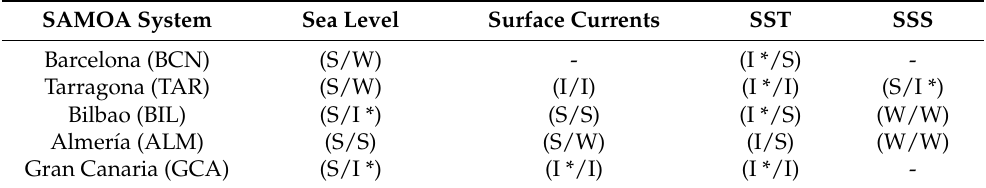
Table 7. Summary of the impacts of the SAM_H3D proposed set-up. Performance of SAM_H3D versus the control (SAM_ADV) one and the parent solution (IBI_PHY), comparing in those domains where observations are available (for sea level, SST, SSS and surface currents). Legend: (SAM_H3D relative performance with respect to SAM_ADV set-up/SAM_H3D relative performance with respect to IBI_PHY). Acronyms to define the relative performance of the proposed set-up: (I *: relevant improvement/I: improvement/S: similar performance/W: mild